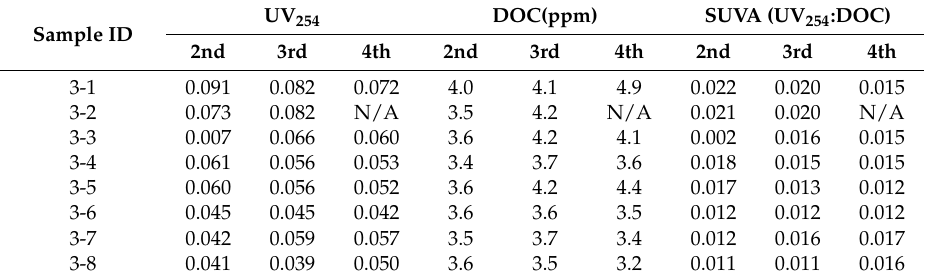
Table 6. Measurements of UV 254 , DOC, and SUVA in the waters collected in System III.